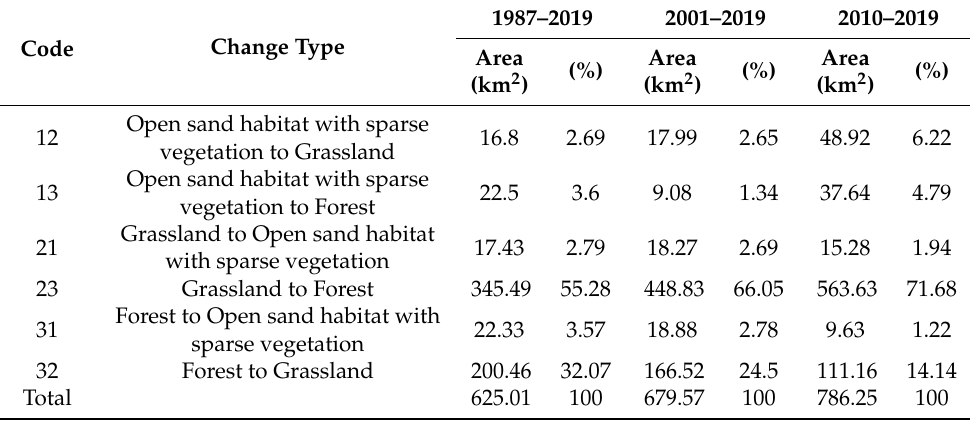
Table 7. Changes in the area occurring in the three time